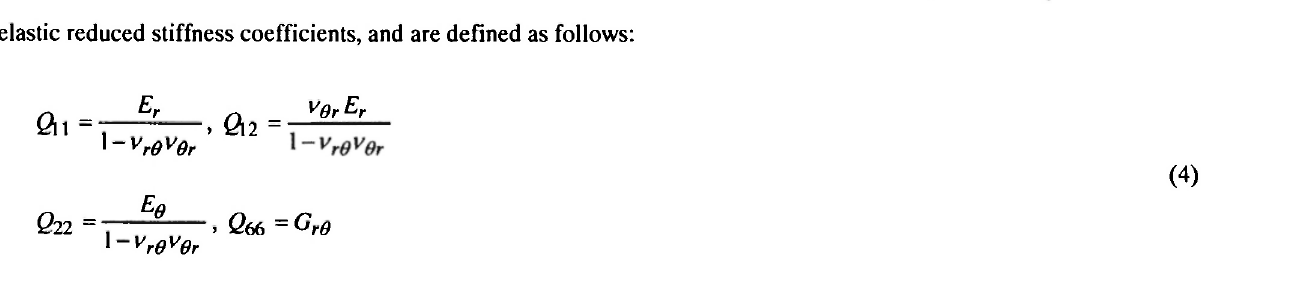
Fig. 1: Polar orthotropic annular